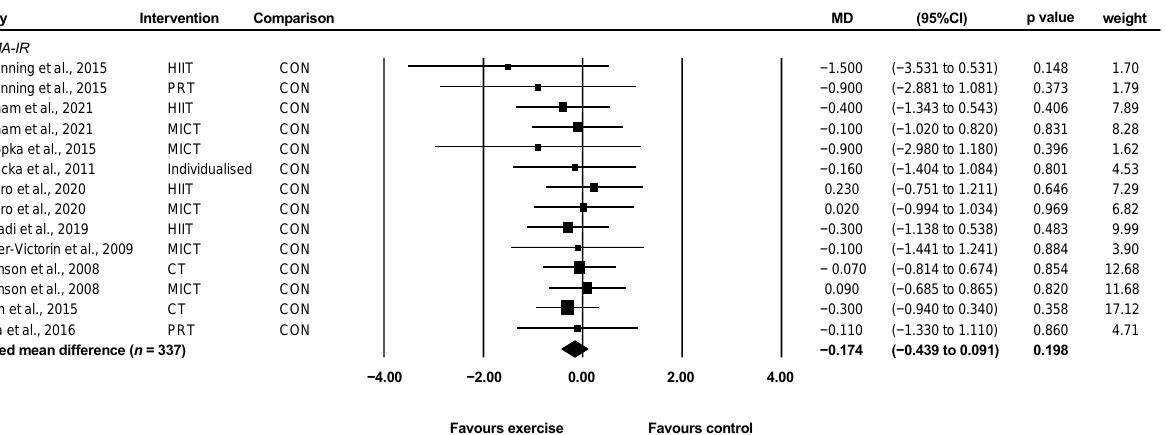
Figure 6. Effect of exercise vs. control for change in fasting blood glucose, HDL-C, and triglycerides. CI: confidence interval, CT: concurrent training, HDL-C: high-density lipoprotein cholesterol, HIIT: